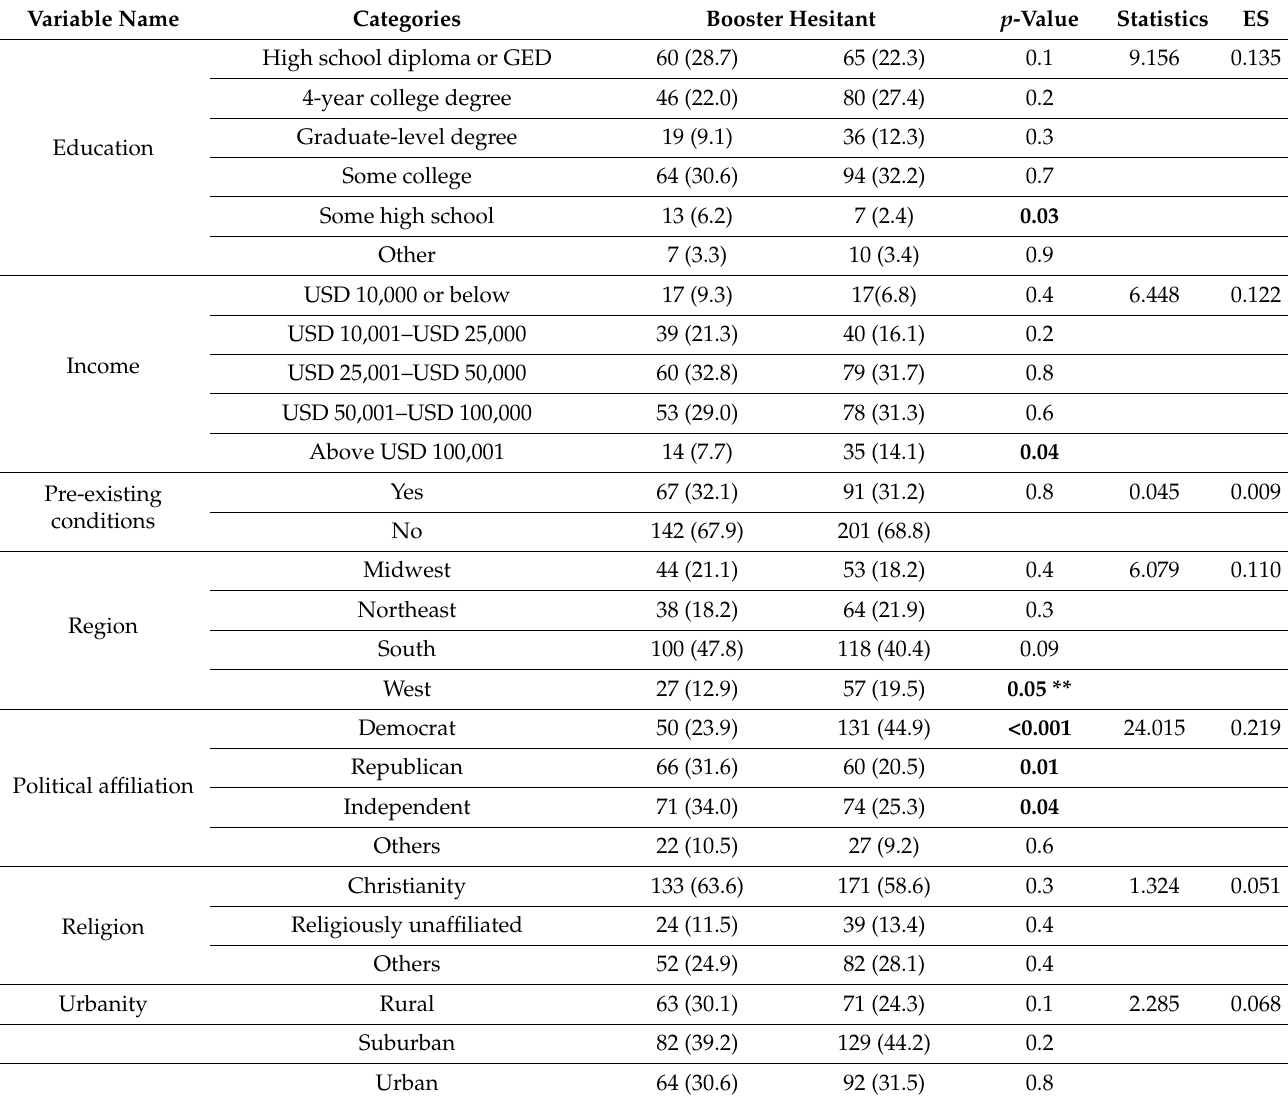
The results in Table 3 indicate the mean differences in vaccine literacy and confidence among booster-hesitant and non-hesitant groups. Compared to the booster non-hesitant group, the hesitant group had statistically significantly lower mean scores for functional